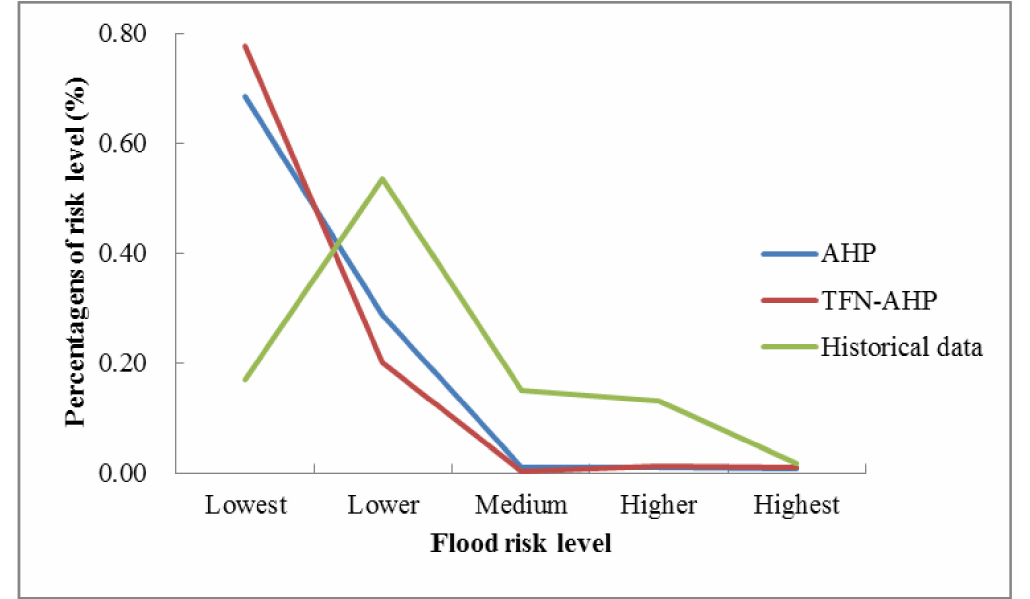
Figure 13. Percentages of flood risk of all